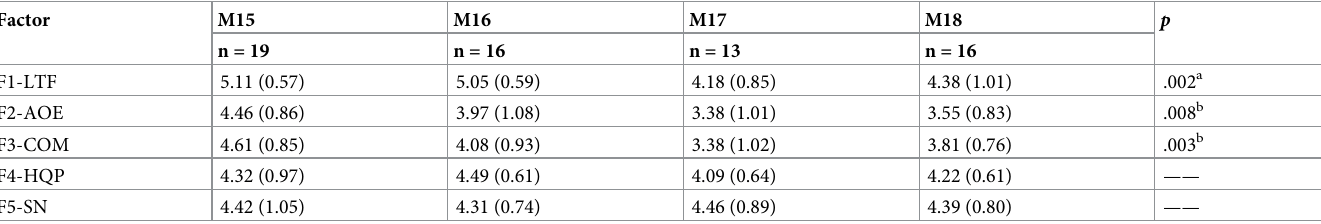
a M15 significantly different from M17 and M18, M16 significantly different from M17. b M15 significantly different from M17 and